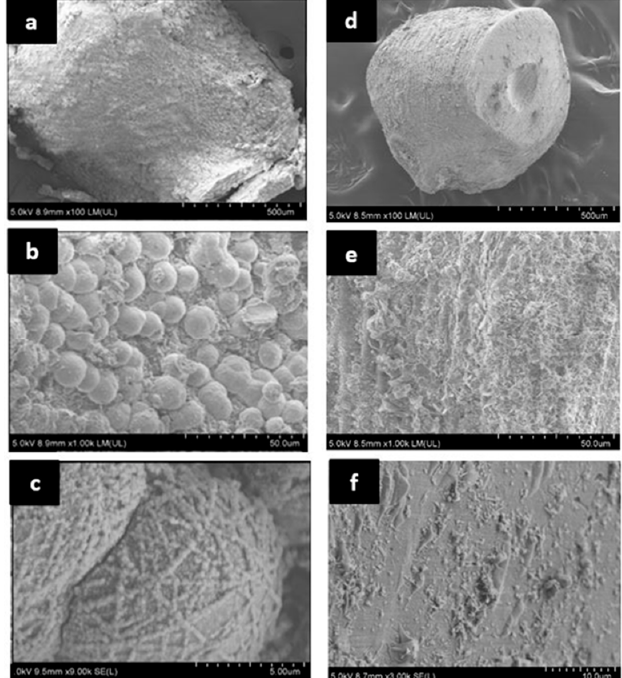
Figure 8. FE-SEM micrographs of NS1 and O capsules placed in cement paste samples and cured in distilled water (DW) for 14 days. ( a ) NS1 capsule after 14 days inside cement ×100 magnification; ( b ) NS1 capsule after 14 days inside cement ×1000 magnification; ( c ) NS1 capsule after 14 days inside cement > ×1000 magnification; ( d ) O capsule after 14 days inside cement ×100 magnification; ( e ) O capsule after 14 days inside cement × 1000 magnification; ( f ) O capsule after 14 days inside cement > × 1000